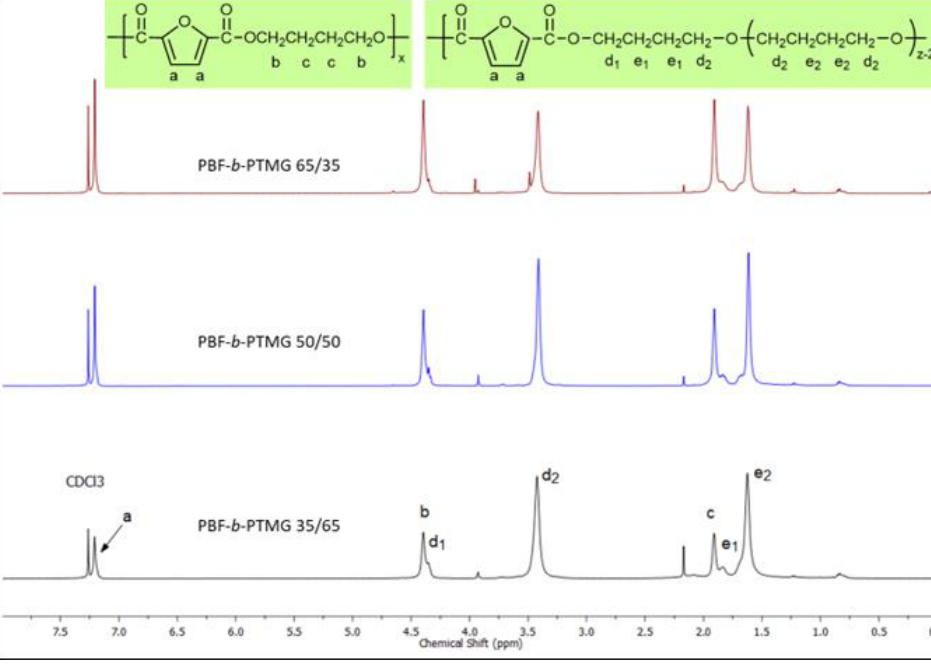
Figure 3. 1 H-NMR spectra of PBF-b-PTMG copolymers.